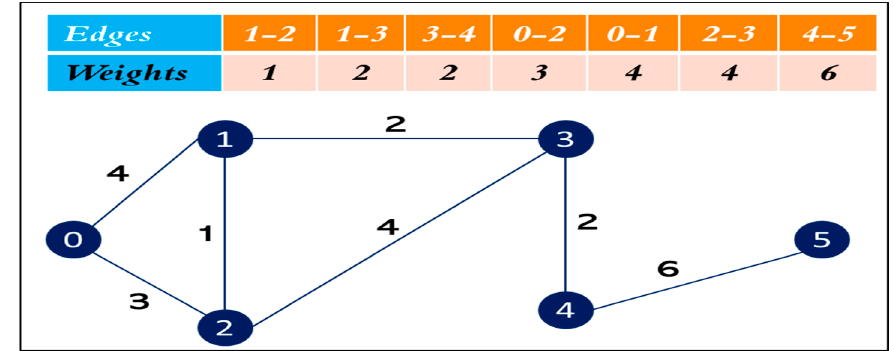
Figure 5. Example of the list to graph formation in software using GASP (graph algorithm software package) language.